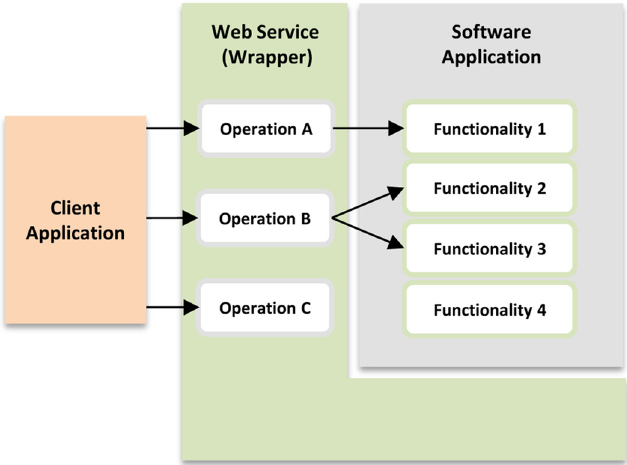
Fig 1. Architecture of a generic web service (wrapper). Service operations A and B provide access to different functions of an existing software application, while the service operation C was independently implemented of the tool being wrapped. Functionality 4 of the software application is not accessed by the